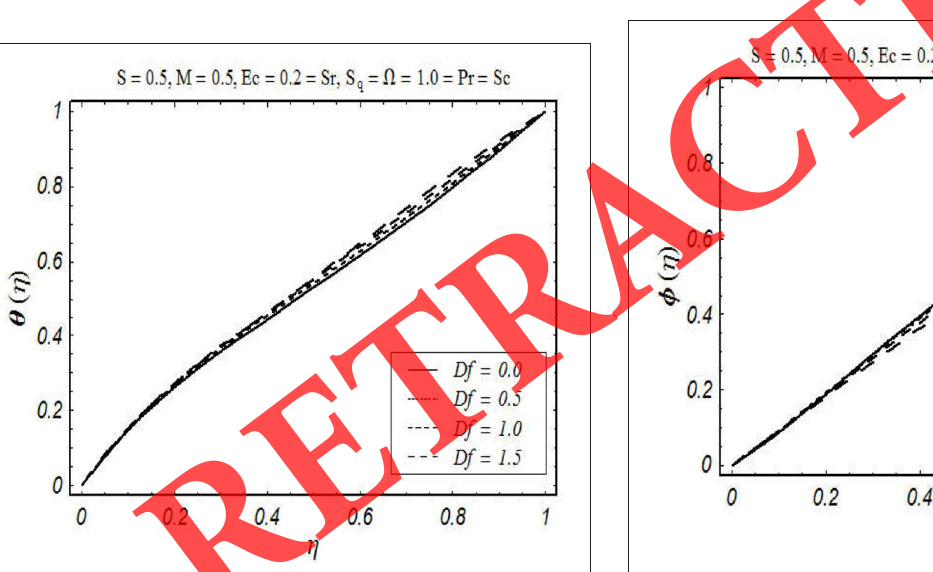
FIGURE 9 | Sketch of temperature distribution θ (η) for Eckert number Ec .